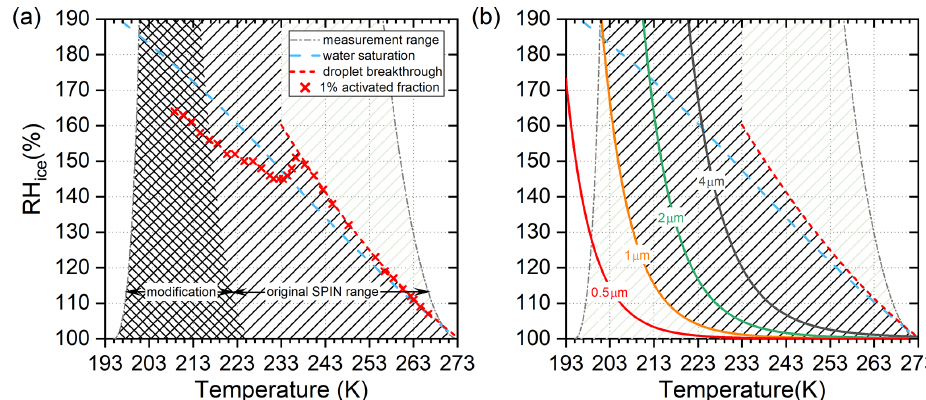
Figure 3. Calculated range of T and RH i conditions. (a) Extended limit of experimental capacity with the modified SPIN cooling system (cross-hatched area) compared to the original setup (hatched area). Water saturation is indicated as blue dashed line. Red crosses show 1% activated fractions, measured with 200nm ammonium sulfate particles (see Fig. 4). Above 235K the data indicate onset of water breakthrough conditions, below 235K homogeneous freezing of solution droplets. (b) Limiting conditions to distinguish 0.5, 1, 2 and 4µm (diameter) test particles from growth-limited ice crystals. Conditions excluded from ice detection by droplet breakthrough and ice crystal growth are lightly hatched. Total experimental range to measure ice nucleation with the modified SPIN setup is shown as a dark hatched